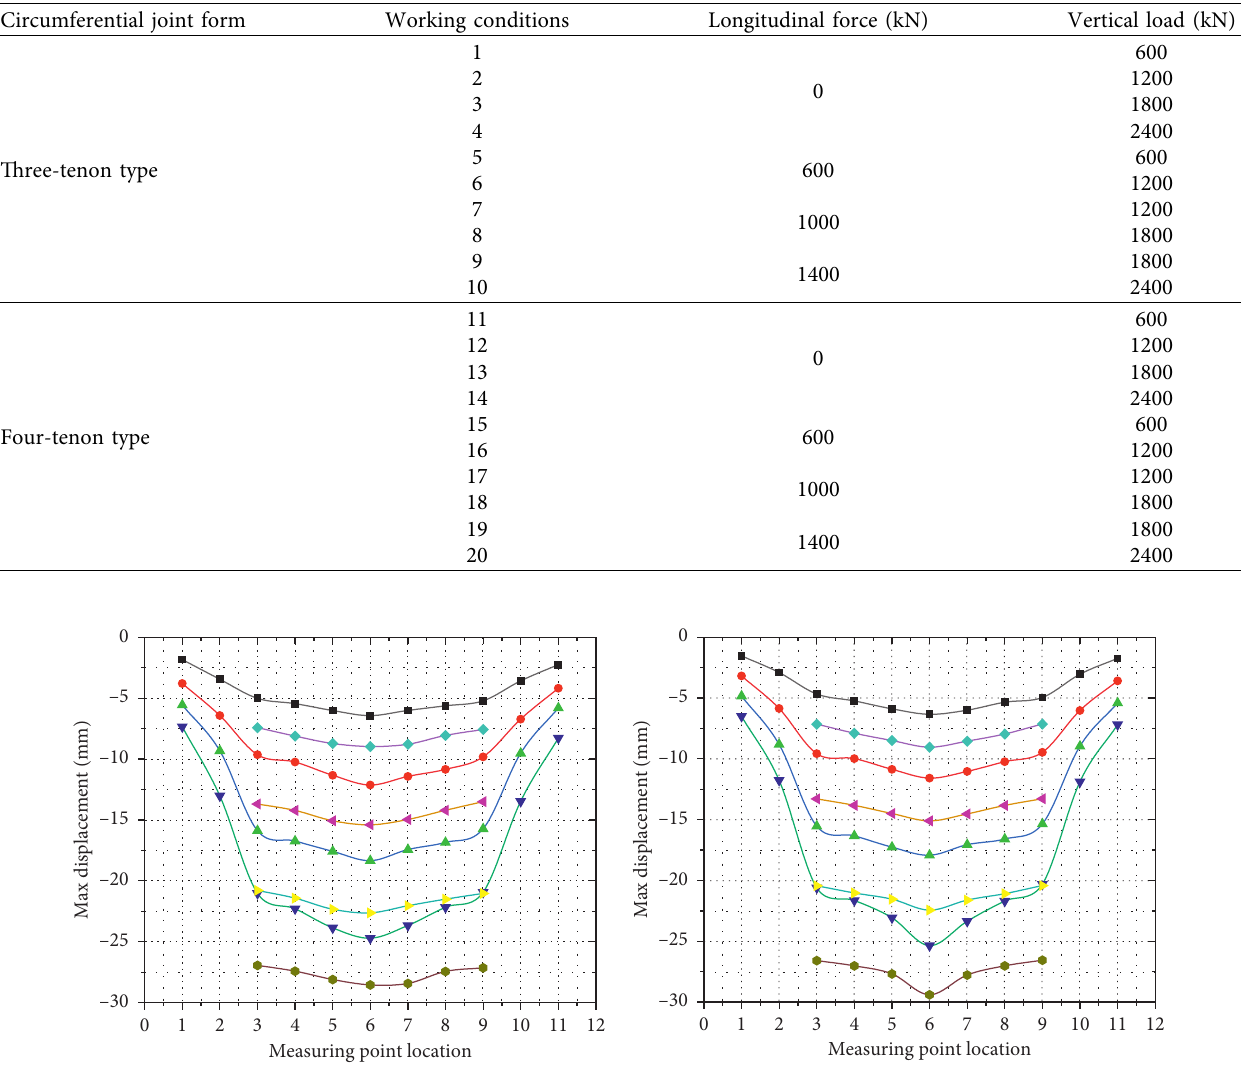
Table 3: Loading cases of composite segment.